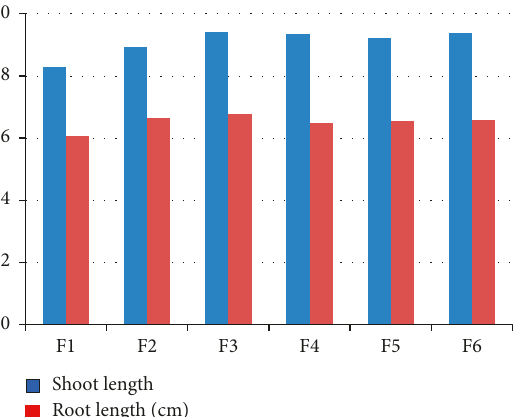
Figure 3: Growth indices of the soybean seedlings germinated from seeds treated with formulations of different compositions 7 days after sowing.